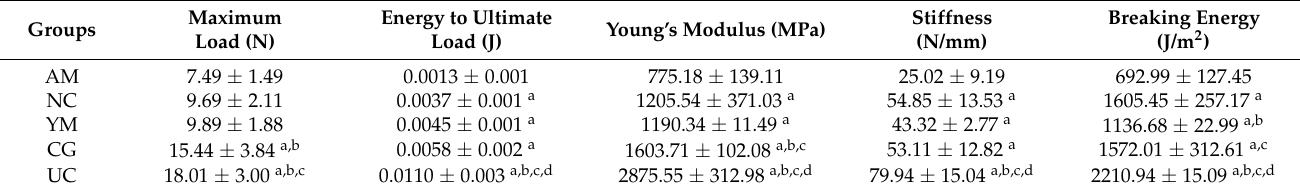
Table 1. The bone biomechanical parameters of the femur in the five groups.